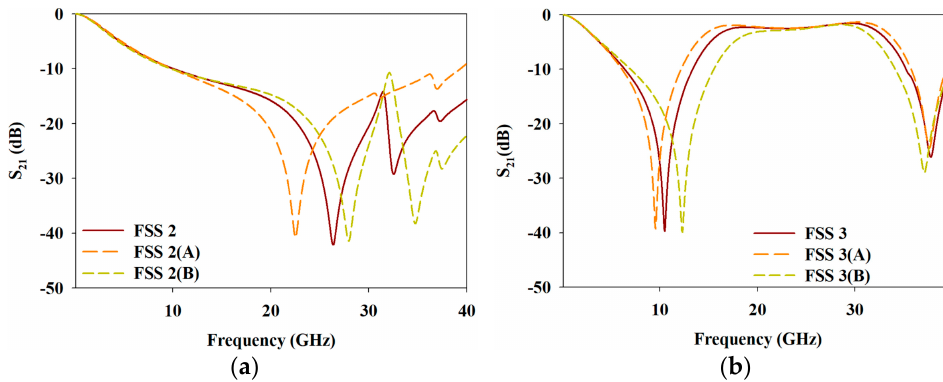
Figure 5. The frequency response under the influence of structural changes of ( a ) FSS 2 and ( b ) FSS